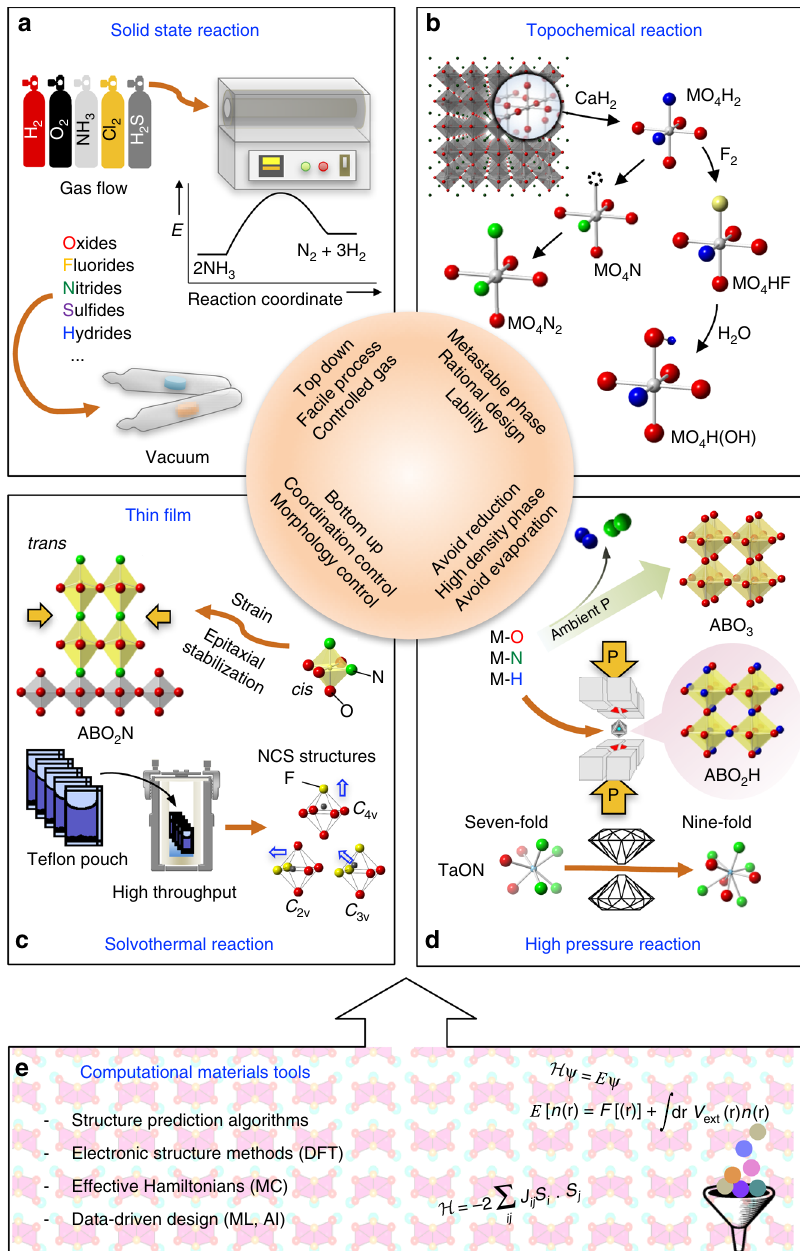
Fig. 3 Synthetic approaches for mixed anion compounds. a Traditional high-temperature solid-state reactions. Controlled atmospheres, such as fl owing gases (NH 3 , Cl 2 , CS 2 , and so on) and in a vacuum are often necessary. Gas-phase or surface reactions may be important. For example, owing to the dissociation of NH 3 to H 2 and inert N 2 at elevated temperatures, processing conditions, such as an ammonia fl ow rate need to be carefully chosen. b Topochemical reactions to allow a rational design of structures (Fig. 1f). Low-temperature treatment of oxides with some reagents cause different anions to insert or exchange while maintaining the structural features. Multistep reactions have been also accessible 13,14 . c Epitaxial thin fi lm growths and solvothermal reactions as a bottom-up process. Chemical bonding from ions of a substrate lattice yield metastable phases 19 . Local geometry can be manipulated by applying tensile or compressive strain from the substrate 20,21 . Solvothermal reactions offer an opportunity to prepare compounds with well-de fi ned local structures. High throughput screening is possible with the Te fl on pouch approach. d High-pressure reactions. High pressure can prevent some reagents from dissociation or evaporation (upper) 22 – 26,41 , and also stabilize dense structures (lower) 27 . e Computational tools. In particular, the rapid advancement of computational methods provides unprecedented opportunities for predicting and understanding mixed-anion compounds. DFT = density functional theory, MC = Monte Carlo, ML = machine learning, AI = arti fi cial